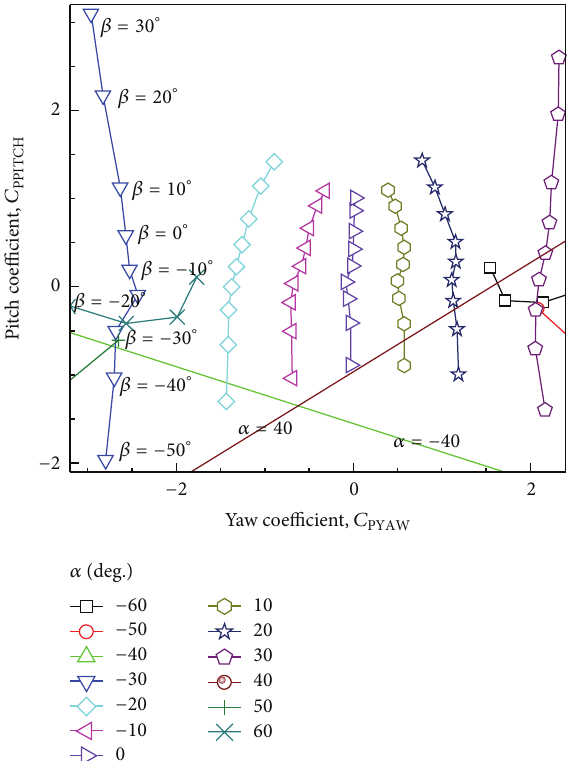
Figure 3: 𝐶 versus 𝐶 calibration curve using traditional PPITCH PYAW calibration